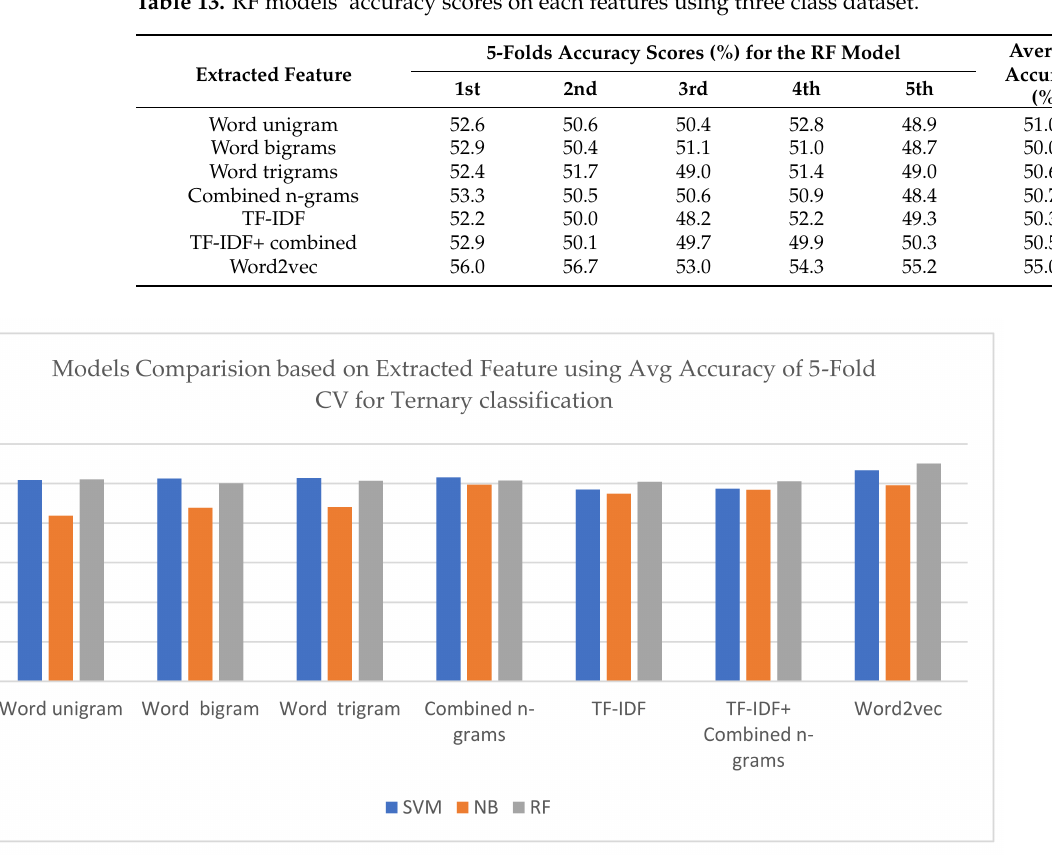
Figure 9. Ternary models’ comparison using CV average